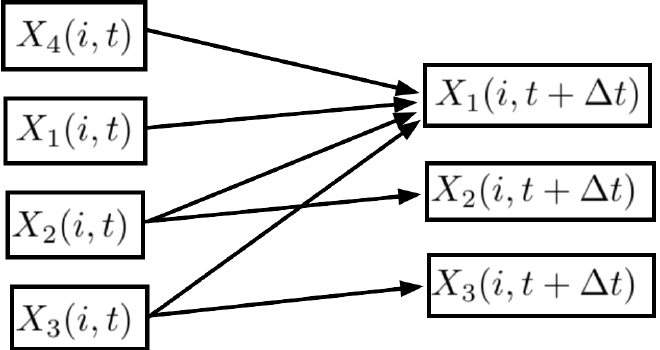
Figure 1. Bayesian network associated to the proposed